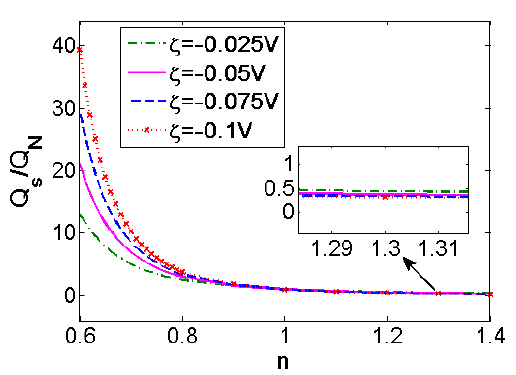
Figure 5. Variation of the flow rates generalized by that of Newtonian fluid ( n = 1) with flow behavior index n at different zeta potential ζ ( K = 50).